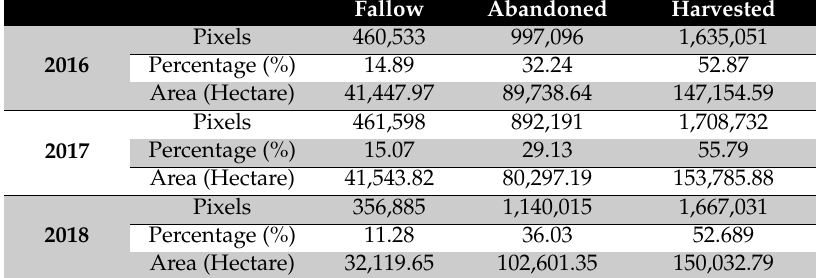
Table 2. Breakdown of cropland outcomes across crisis years in Rakhine,